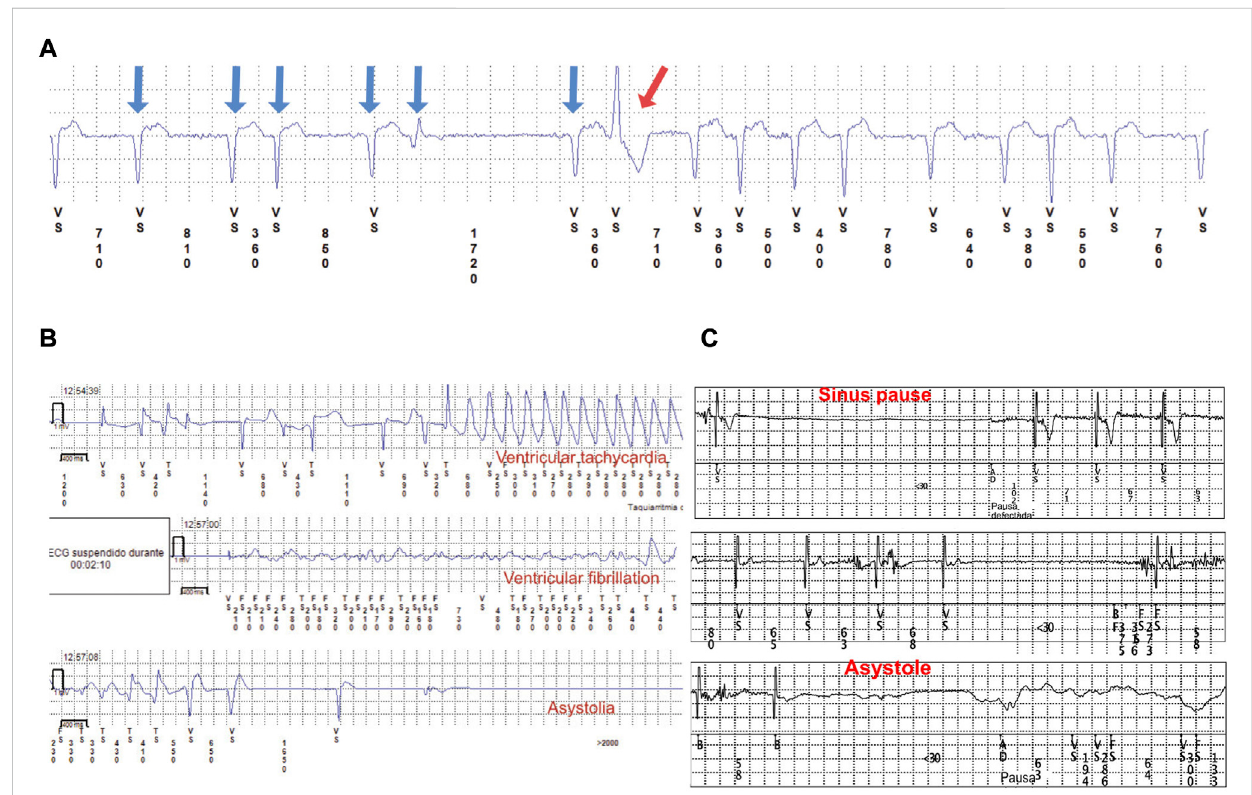
FIGURE 4 Three ECG traces from the ILR. (A) Atrial fi brillation (blue arrows) and a ventricular extrasystole (red arrow). (B) Ventricular tachycardia, VF, and asystole from a pediatric patient diagnosed with EDMD. (C) Sinus pause and asystole in a 3-year-old patient.